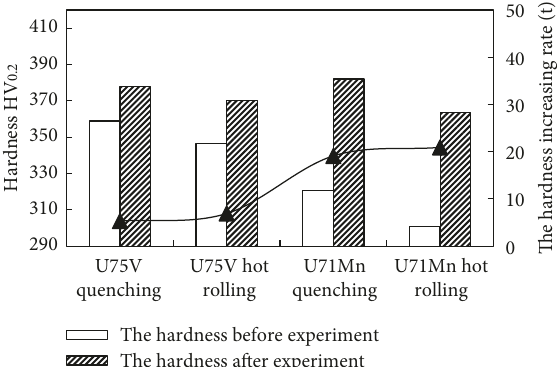
Figure 1: Comparison diagram of hardness of different rail